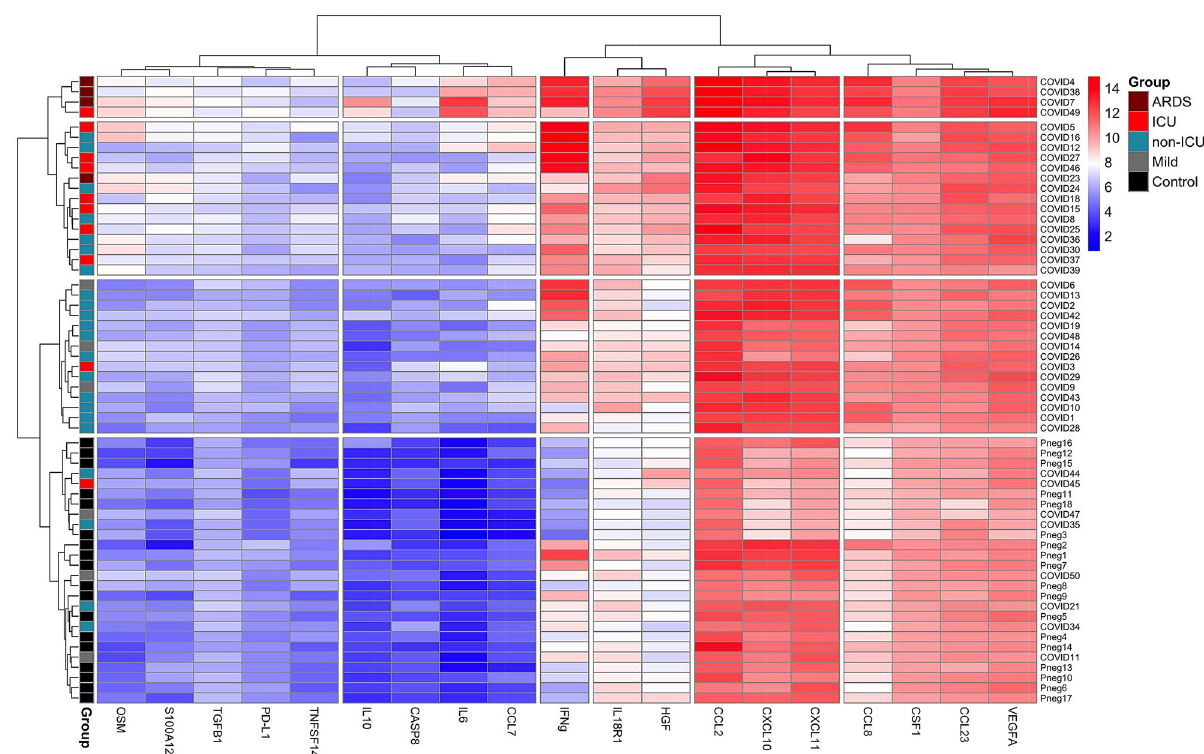
Figure 5. Plasma marker analysis reveals distinct clusters in COVID-19 patients. Cluster analysis of maximal levels (NPX) of 19 proteins (the proteins presented in Figs. 2 and 3 except IL7 due to low overall levels) in 60 individuals (14 ICU-s of which 4 developed ARDS, 22 non-ICU-s, 6 mild cases and 18 controls). The analysis identified 4 clusters of individuals and starting from the top, the first cluster included ICU patients with ARDS and 1 patient (COVID49) who died before receiving ARDS diagnosis. The second cluster contained 16 (1 ARDS, 7 ICU and 7 non-ICU) patients. Cluster three included mostly non-ICUs and cluster four mostly Data, which gave the right for the exception to obtain informed consent in life-threatening emergencies, in case of situation with overwhelming public interest and on a condition that the waiver will not adversely affect the rights and welfare of the subjects. Plasma samples were obtained from 40 COVID-19 patients (Table 1) hospitalized at the Tartu University Hospital, Estonia. Fifteen patients were treated in ICU and 25 in ordinary COVID-19 ward. Most of the ICU patients required mechanical ventilation within the first 10 days after the onset of symptoms with a median duration of the intensive care unit (ICU) stay of 10 days (range 1–54 days). Moderate COVID-19 patients were hospitalized for a median duration of 11 days (range 1–44 days). The diag- noses for all patients were confirmed by PCR analysis for SARS-CoV-2 virus. During their hospitalization in April–May 2020, some patients were treated with hydroxychloroquine but not with remdesivir, dexamethasone or IL-6 inhibitors. The patients nevertheless, had several comorbidities and were given corresponding treat- ments. The samples from a group of 6 patients with mild disease were collected from the individuals who came to emergency medical unit, were tested positive for SARS-CoV-2 but sent home for quarantine and not admitted to the hospital. We studied altogether 119 healthy controls (age range 23–87 years) without recent infection or COVID-19 symptoms (fever or cough) for last month. Blood samples of two groups of patients (mostly over 60 years of age) without COVID-19 disease were collected from Internal Medicine unit and CRP under 5 mg/L: one group of 18 individuals was studied for clinical blood analysis and another group of 18 controls for the expression of multiple plasma proteins. In addition, 70 control individuals, including healthy blood donors, were studied for antibody reactivities. LIPS. SARS-CoV-2 S (S1 aa 1–680 and S2 aa 820–1211), S1 RBD (aa 329–538), and N (aa 2–419) fragments were cloned into pNanoLuc vector, and LIPS was performed as reported 23 . The HEK293 cell lysates contain- ing NanoLuc ‐ fusion proteins (0.5—1 × 10 6 luminescence units; LU) were incubated with plasma samples and Protein G Sepharose beads (Creative BioMart) to capture antibodies (in 1:40 dilution). After washing, substrate was added (Nano-Glo™ Luciferase Substrate, Promega), and luminescence was measured in VICTOR X Reader (PerkinElmer Life Sciences). Results are expressed as fold changes (FC) of LU-s (FC = LU sample/average LU of 5 healthy control samples, the discrimination level is mean plus 2 standard deviations of control samples). Microneutralization. The assay was performed in a BSL-3 laboratory as described previously 18 . Briefly, fifty plaque-forming units (PFU) of the SARS-CoV-2/Finland/1/2020 strain, passaged in Vero E6 cells, were added to the plasma dilutions and incubated for 1 h at 37 °C. Neutralizing antibody levels were assessed by cytopathic